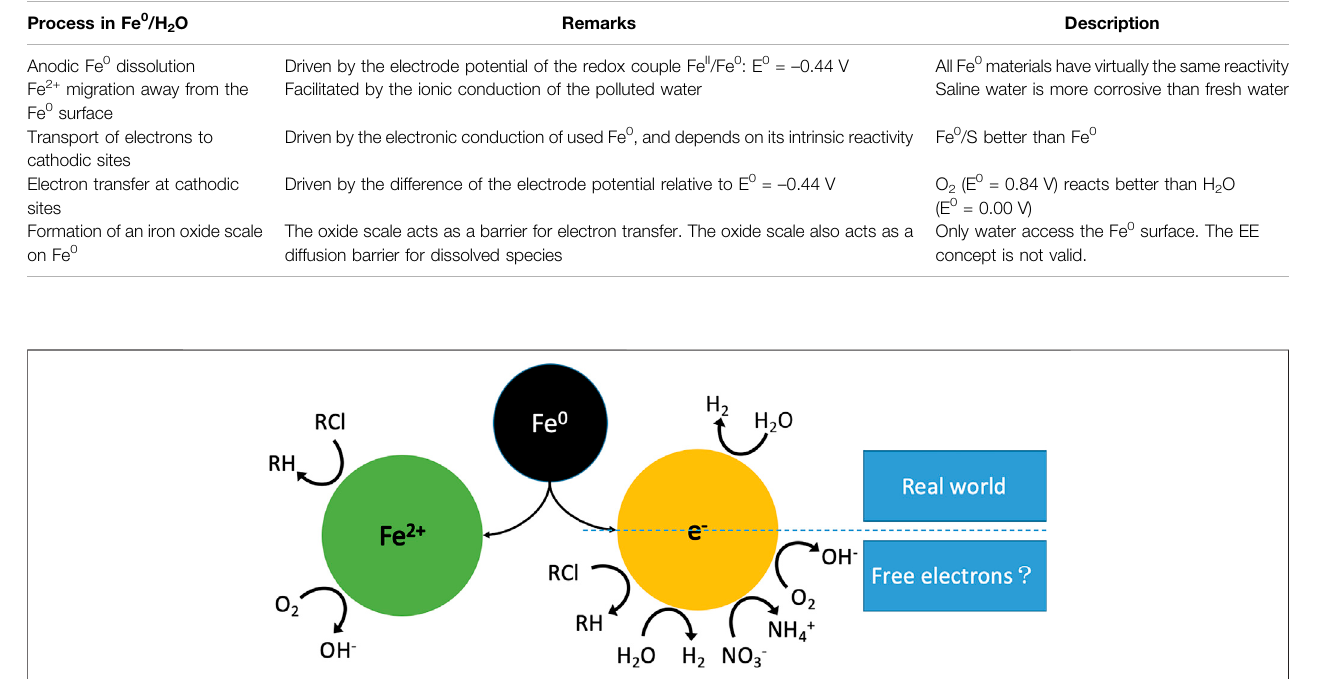
FIGURE 2 | Pathways of contaminant transformations in Fe 0 /H 2 O systems. In the real world, only water has access to the metal surface. Fe 2+ and H 2 are stand alonereducingagents.O 2 andRClarereducedbyFe 2+ .ThescenariooftheEEconceptcorrespondstofreeelectronswithintheFe 0 /H 2